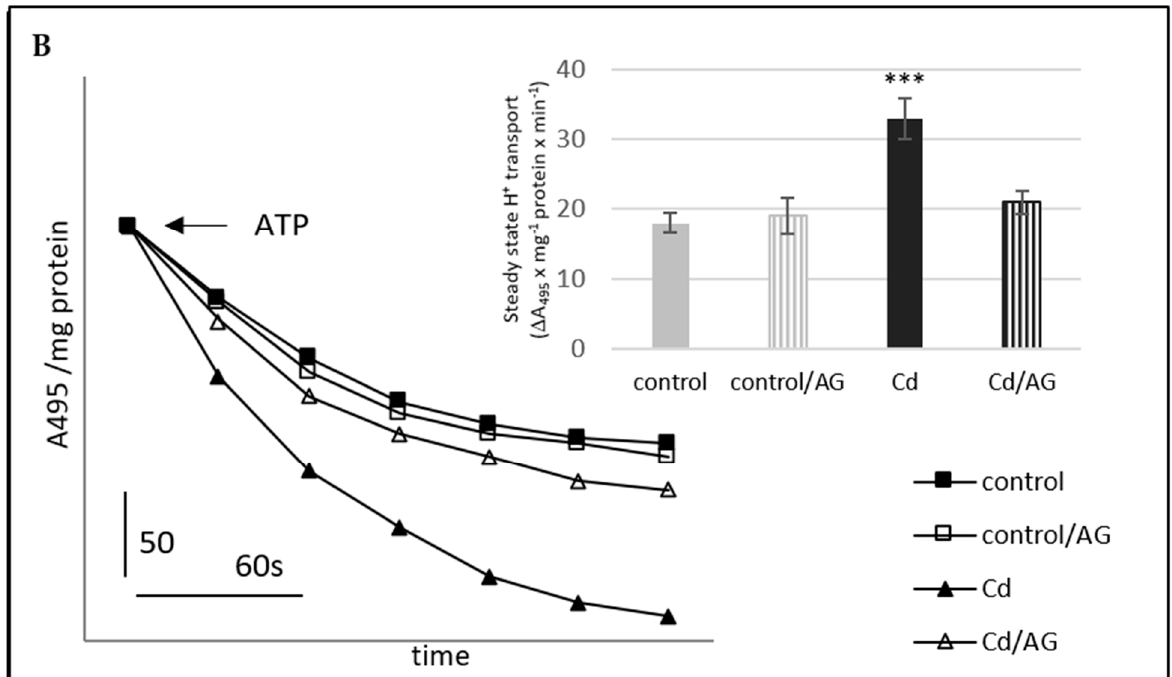
Figure 3. Effect of cadmium and/or AG on the hydrolytic activity of H + -ATPase ( A ) and the ATP- dependent proton transport ( B ) measured in the plasma membrane vesicles. The plasma membranes (50 μ g of protein) were isolated from control roots (control), roots of plants treated for 3 days before harvesting with aminoguanidyne added to control nutrient solution (control/AG), roots of plants, which after 3 days of treatment with 10 μ M Cd were transferred to the control conditions for another 3 days (Cd), and the roots of plants, which after 3 days of treatment with 10 μ M Cd were transferred to the control nutrient solutions with aminoguanidyne (Cd/AG). Hydrolytic activity of H + -ATPase was measured as described in the Materials and Methods. Results are the means + SD of three independent experiments with each experiment performed in triplicate ( A ). After equilibration of membranes with the reaction medium (for at least 5 min), vesicle acidification was initiated by the addition of ATP to give a final concentration of 3 mM. The formation of a Δ pH gradient in the vesicles was monitored as the changes in acridine orange absorbance (A 495 ). The values presented ( B ) are representative for the results obtained in three independent experiments with each experiment conducted in triplicate. The results in the inner diagrams (the steady state of H + transport are the means + SD from those three independent experiments (asterisks indicate the significant differences, where *** p < 0.001).